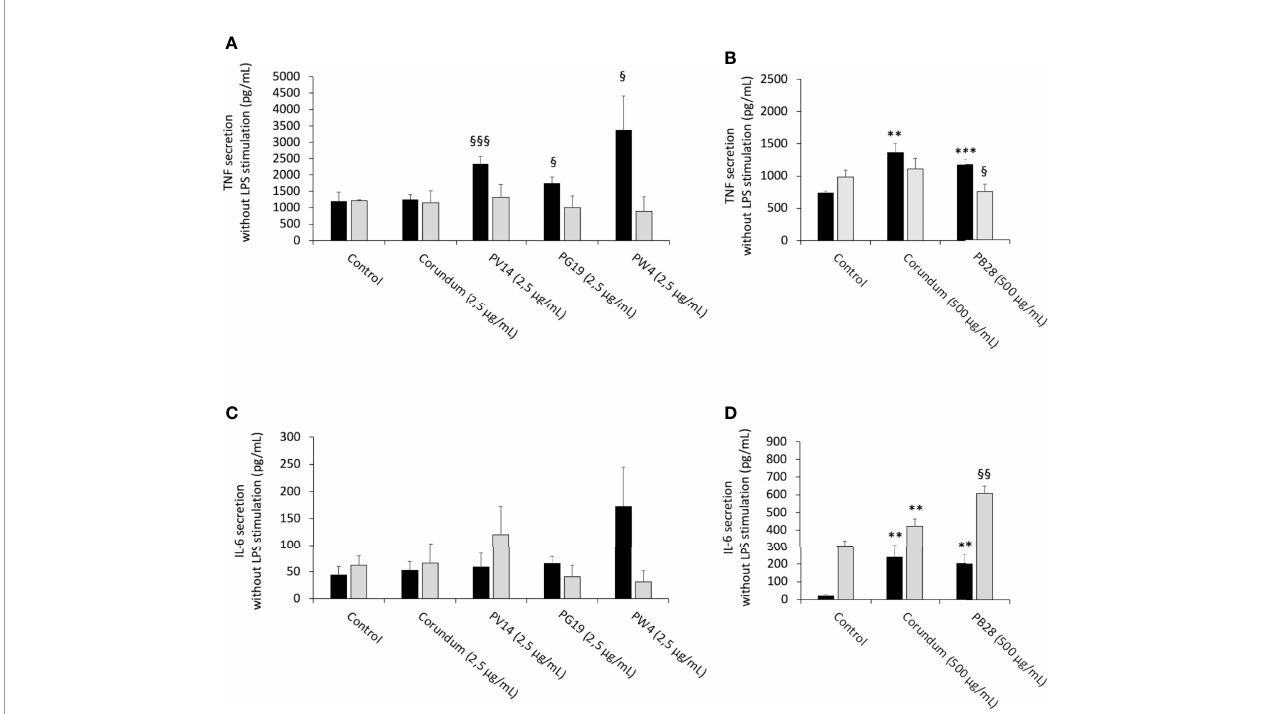
FIGURE 10 | Cytokine secretion without LPS stimulation. Black bars: acute exposure (24 hours). Grey bars: exposure for 24 hours followed by a 3-day post- exposure recovery period. Panel (A) TNF secretion. Conditions with 2.5 µg/ml of particle suspension. Panel (B) TNF secretion. Conditions with 500 µg/ml of particle suspension. Panel (C) IL-6 secretion. Conditions with 2.5 µg/ml of particle suspension. Panel (D) IL-6 secretion. Condition with 500 µg/ml of particle suspension. Signi fi cance of symbols: *: different from negative control only; §: different from both negative and corundum controls. Number of symbols: 1: p < 0.05; 2: p < 0.01; 3: p <